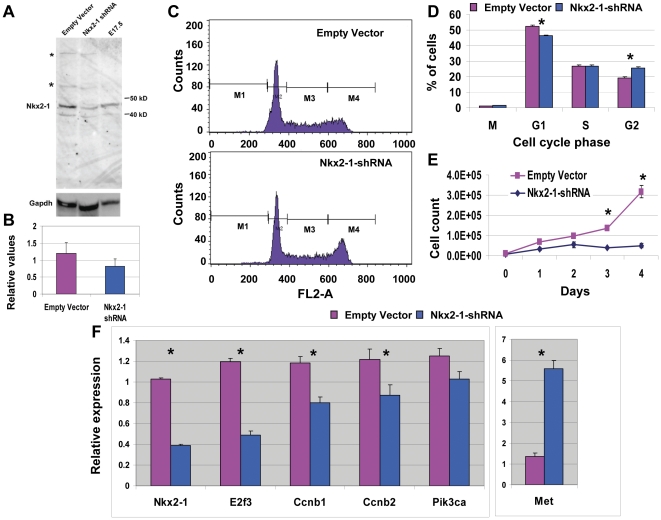
Downregulation of Nkx2-1 affects expression of proliferation-related genes in mouse lung epithelial cells.(A) Western blot analysis of Nkx2-1 downregulation by shRNA in MLE15 cells using the Nkx2-1 antibody 07-601 (Millipore-Upstate). Two bands between 40–50 kD are detected in mouse MLE15 cells and E17.5 lung. Densitometry analyses show a significant downregulation of Nkx2-1 major bands in shRNA transduced cells. Nkx2-1 downregulation by shRNA also reduces the level of minor bands of higher molecular weight (*, asterisks) (B) Representative flow cytometry analyses of DNA content and cell cycle progression in the same cells; n = 3. (C) Relative number of cells in each stage of the cell cycle. (D) Cell count analysis of MLE15 cells transduced with empty vector or Nkx2-1shRNA. 5000 cells were plated and grown in standard conditions for up to 4 days. Attached cells were trypzinized and counted; n = 6 (E) Real time RT-PCR analyses of Nkx2-1 mRNA expression levels in Nkx2-1 shRNA or empty vector transduced cells; n = 3; similar analyses were performed for selected targets; n = 6. Error bars represent s.e.m.; (*) p≤0.05.